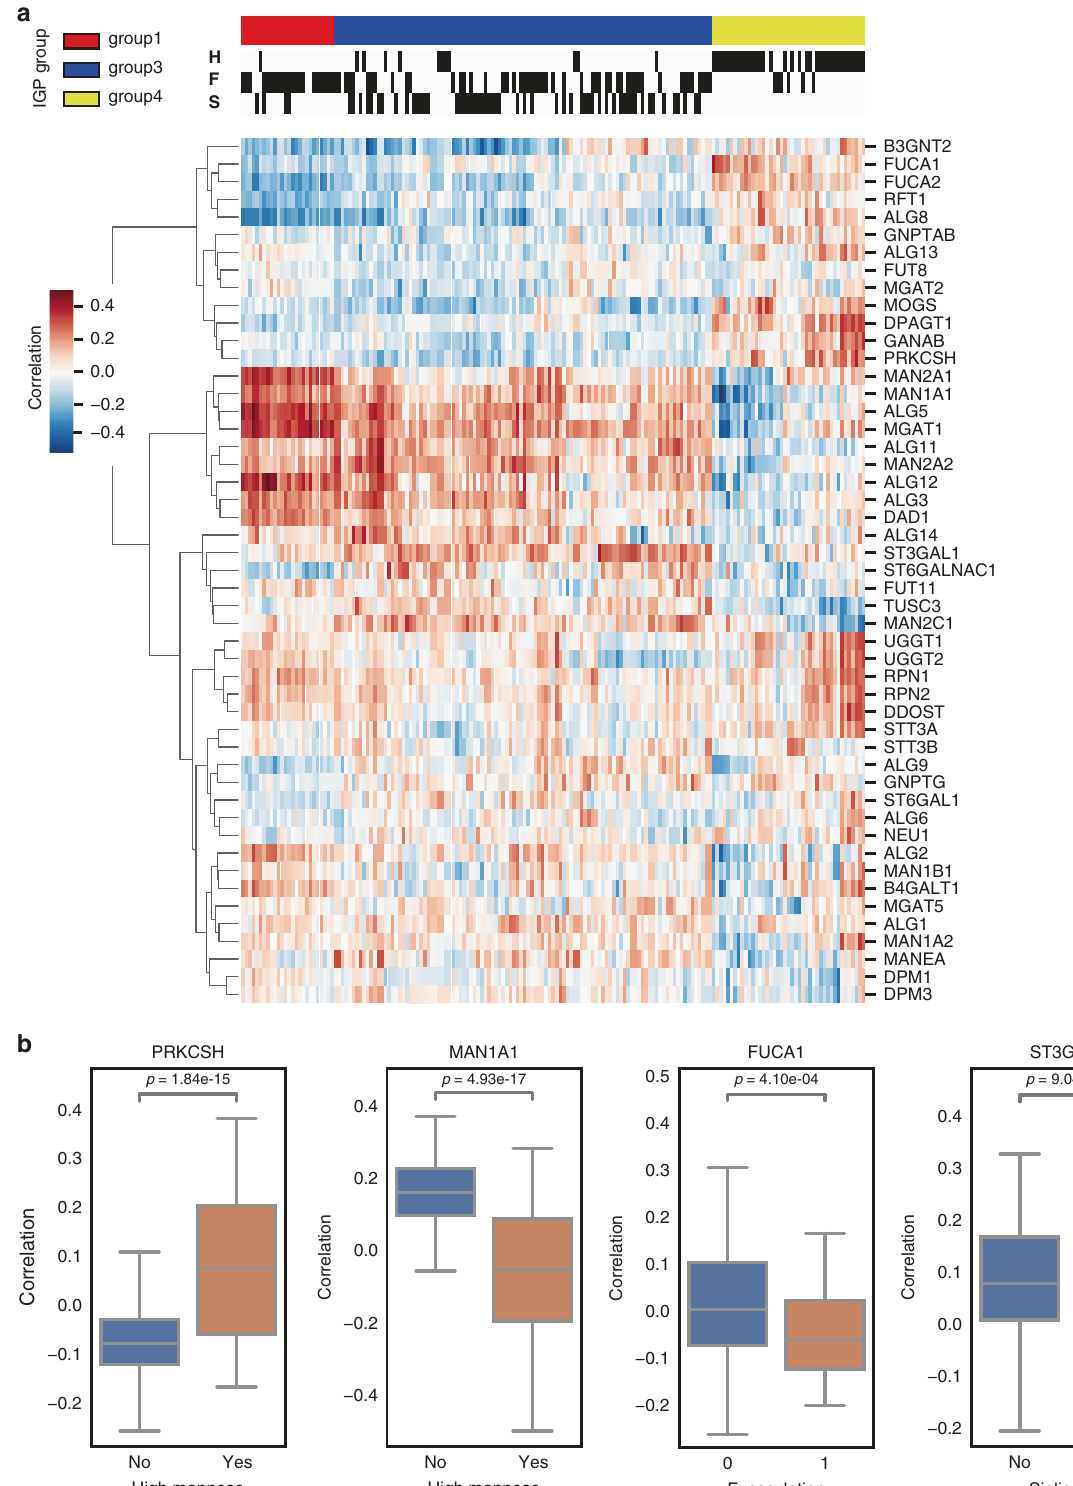
No Yes subunits of OST complex. Glucosidases have a speci fi c effect on were represented by IGP cluster 1 that was de fi ned by sialylation high mannose, while the subunits of OST complex have a broad and the two enzymes, ST3GAL1 and ST6GALNAC. effect on N-linked glycan synthesis. For the mesenchymal subtype that was highly enriched, represented by IGP cluster 3, the down- regulation of fucosidases (FUCA1 and FUCA2) and up-regulation Discussion of fucosyltransferase, FUT11, contributed to the observed fuco- Signi fi cant inter-tumor heterogeneity was observed across human sylation pattern. While the differentiated and stromal subtypes HGSC delineating molecular subtypes de fi ned by transcriptomic